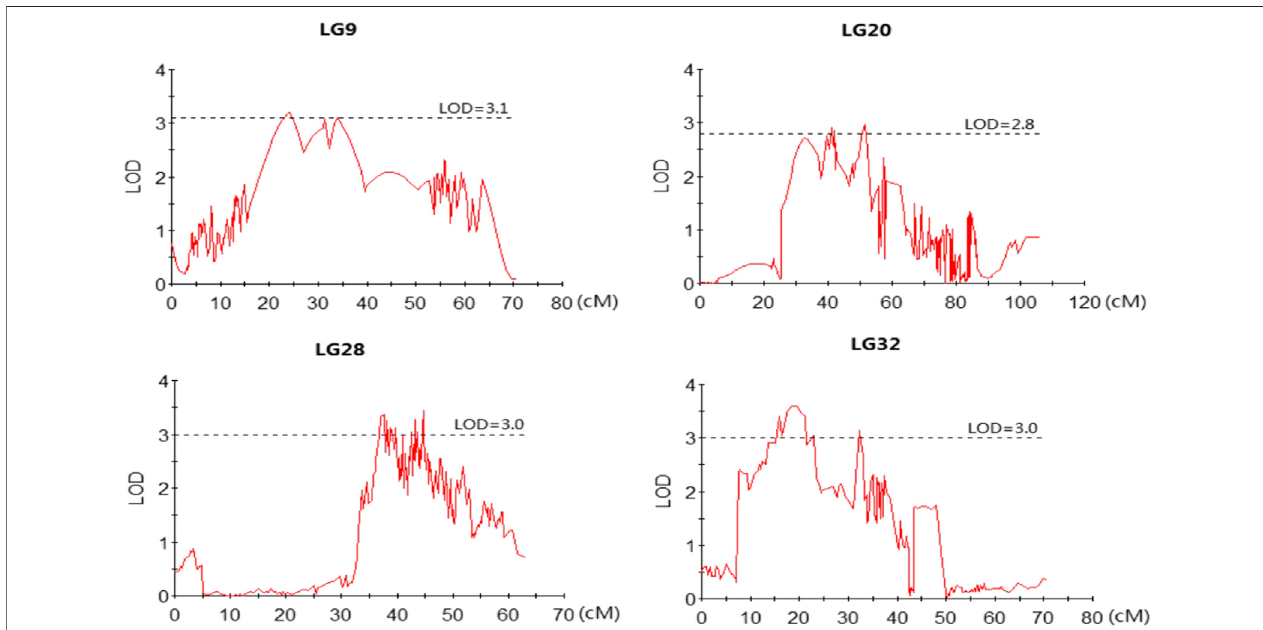
FIGURE 4 | LOD curves for QTLs contributing to FCE. The X-axis indicates marker distance and the Y-axis represents the LOD with the dashed line indicating the threshold value of permutation.